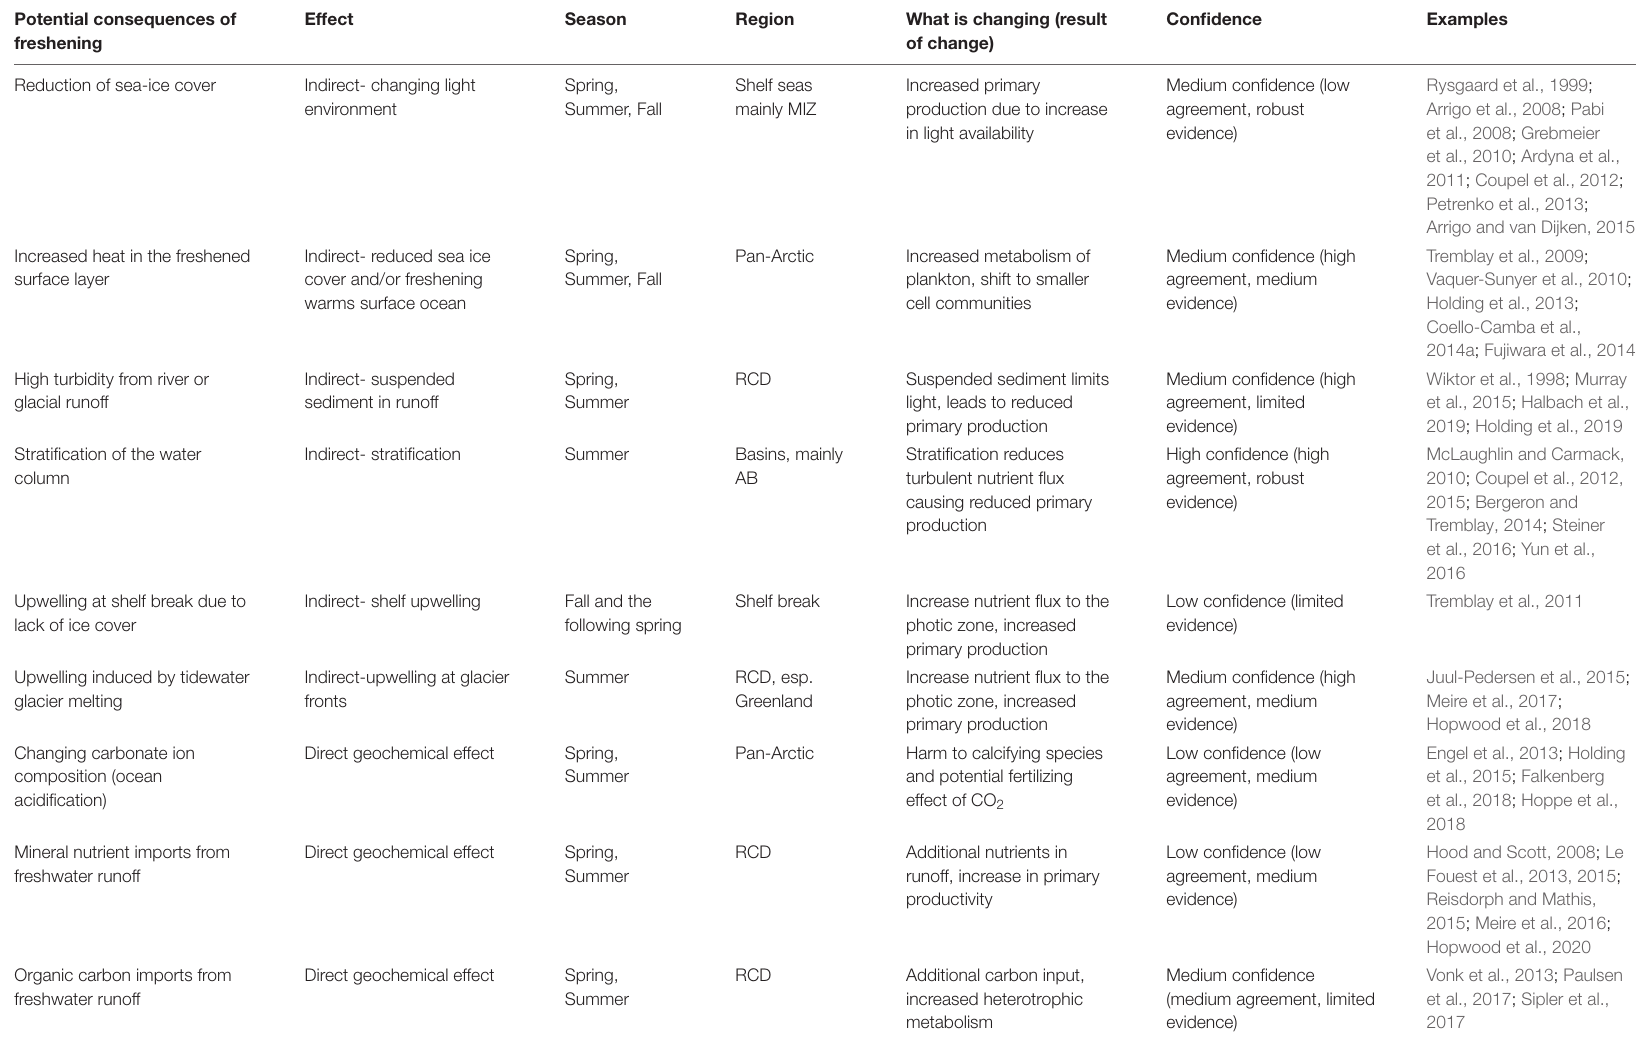
TABLE 2 | The potential consequences of freshening on